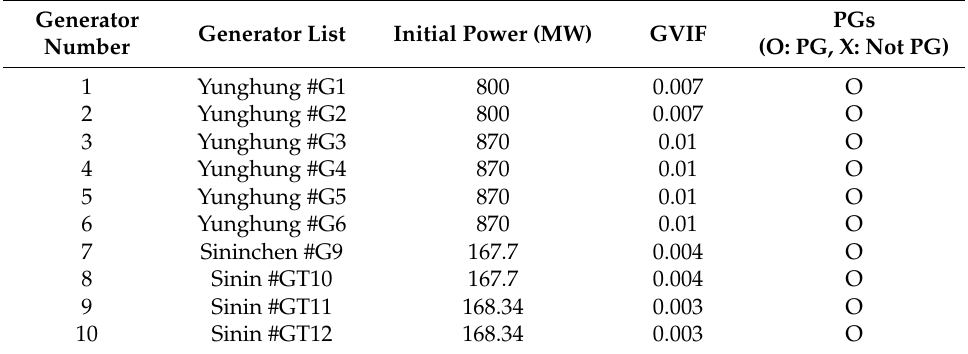
Table 3. Generators-VSC Interaction Factor (GVIF) analysis of participating generators (PGs) in area 1 ( ∆ P vsc = 100 MW) .